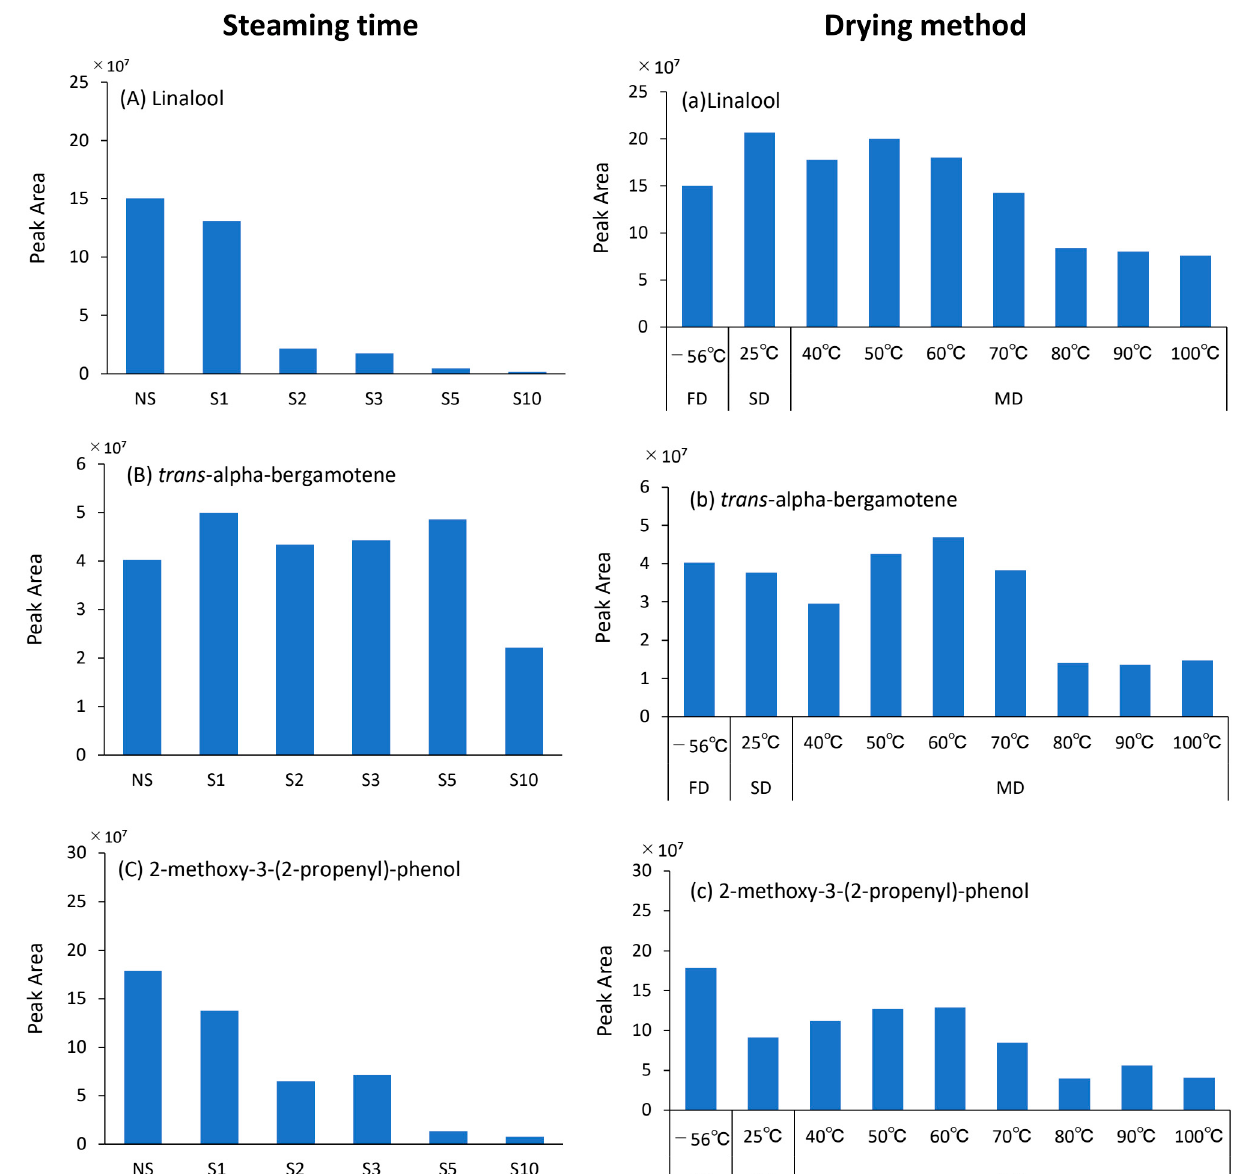
Figure 8. E ff ects of di ff erent treatment conditions on peak areas of aroma compounds in Ocimum Figure 8. Effects of different treatment conditions on peak areas of aroma compounds in basilicum cv. ‘Genovese’ tea. FD: Freeze-drying (–56 °C, 48 h), NS: Non-Steaming, S1: Steaming for Ocimum basilicum cv. ‘Geno-vese’ tea. ( A , a ) Linalool, ( B , b ) trans-alpha-bergamotene, and